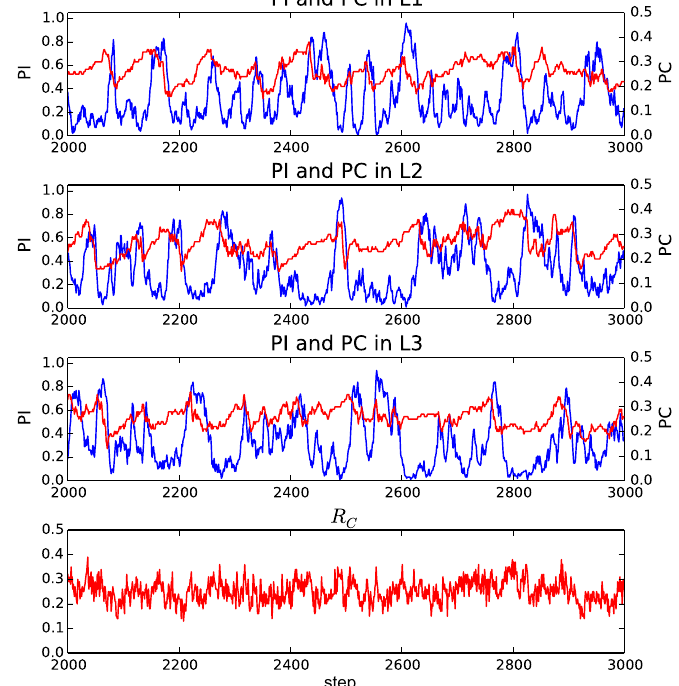
Figure 5. The transition of the proportion of cooperative behaviors ( red ) among the selected strategies ( PC ) and the proportion of individuals ( blue ) ( PI ( l ) ) in the layer l when M = 3. The bottom panel shows the proportion of cooperation among all the selected layers ( PC ). PC fluctuated at around 0.25, and PI ( l ) largely fluctuated and often reached very high values. This trend means that the individuals were distributed all over the layers, but they often got together in a